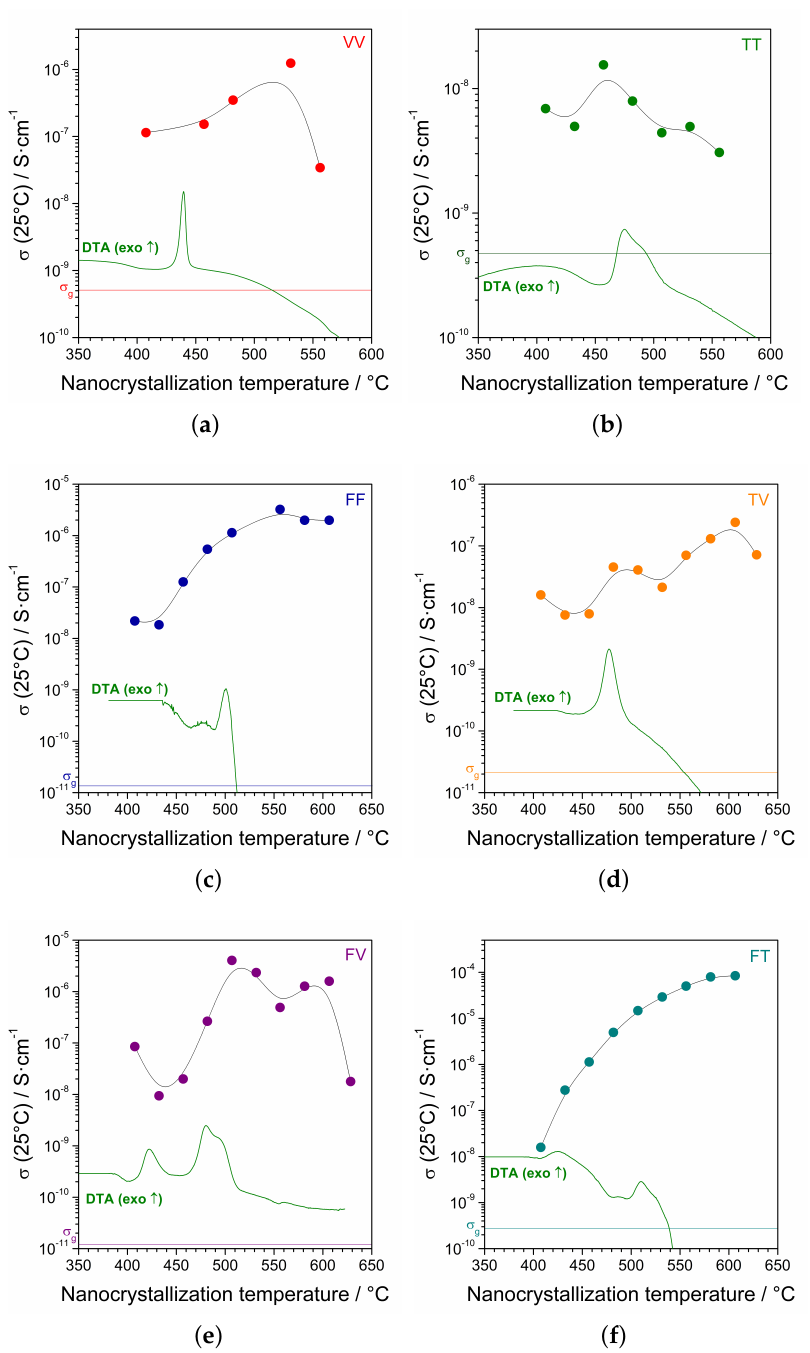
Figure 3. Electrical conductivity of samples at room temperature after their nanocrystallization at different maximum temperatures. The conductivity of the starting glass ( σ g ) is marked with a horizontal line. DTA traces taken at 1 ◦ C/min are given for comparison: ( a ) VV; ( b ) TT; ( c ) FF; ( d ) TV; ( e ) FV; ( f )